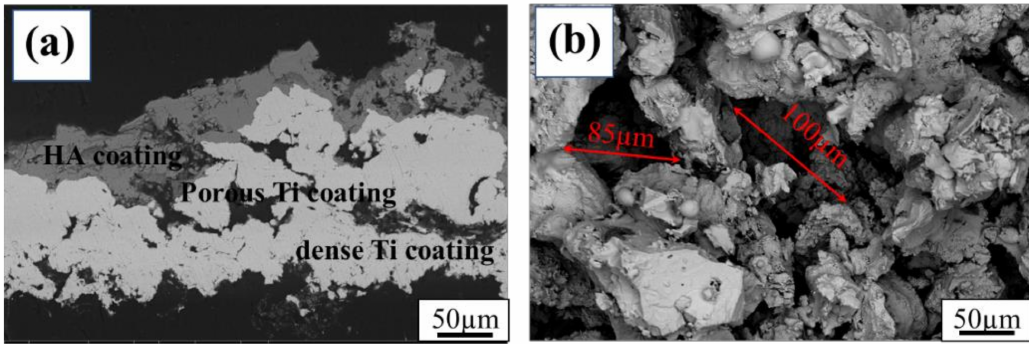
Figure 2. SEM micrographs of the Ti/Ti/HA coating: ( a ) cross section, ( b ) porous structure.